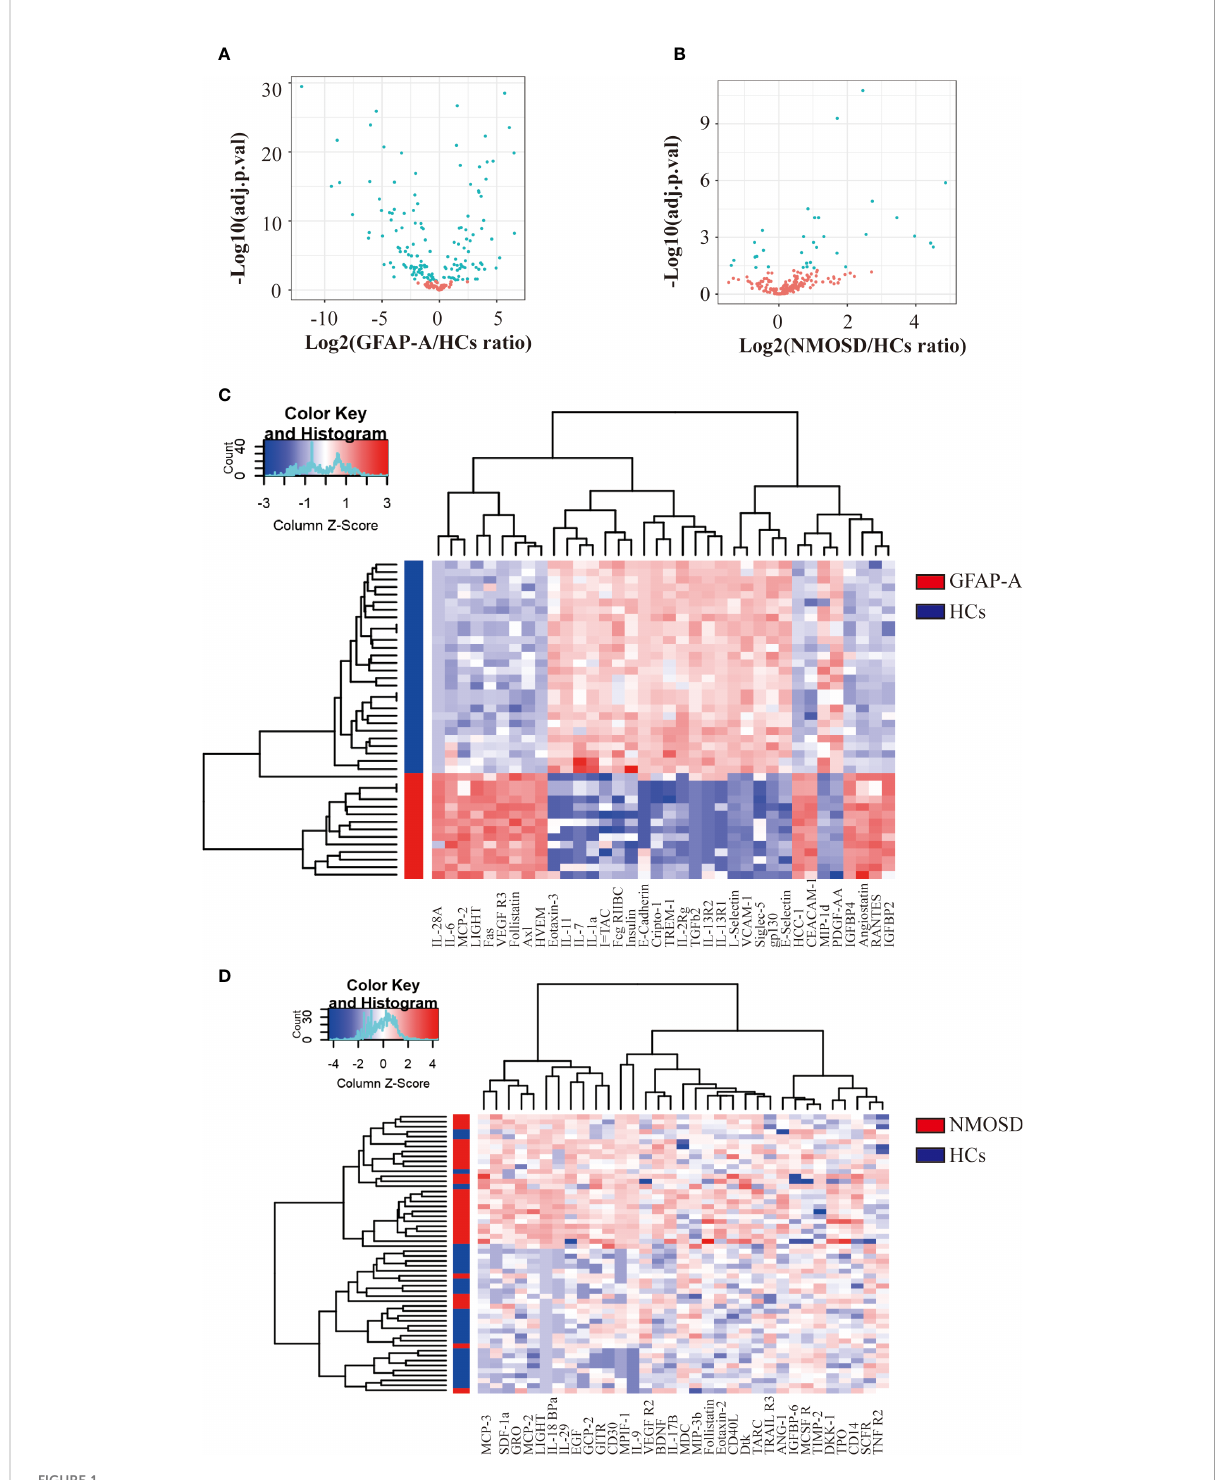
FIGURE 1 Antibody array analysis shows DEPs between HCs and NMOSD patients. (A) Volcano plot presented the distribution of 200 serum protein expression levels between GFAP-A patients and HCs. (B) Volcano plot presented the distribution of 200 serum protein expression levels between NMOSD patients and HCs (adjusted p < 0.05 and absolute log2 FC > 0.263). adj.P.val = adjusted p value. (C) Clustering heatmap of the top 30 DEPs between GFAP-A patients (red) and HCs (blue). (D) Clustering heatmap of the 33 DEPs between NMOSD patients (red) and HCs